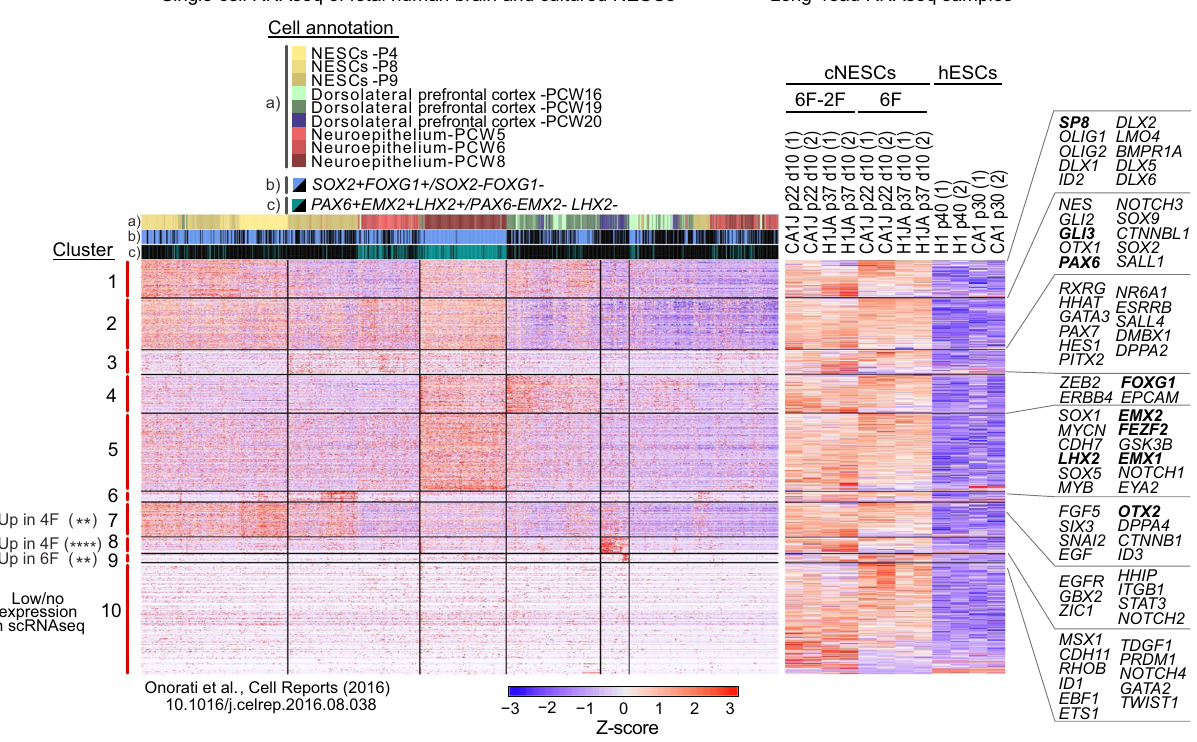
Fig. 6 Human developmental gene expression in cNESCs. Gene expression clustering heatmaps (as Z-score of log2(CPM + 1)) for single-cell RNA sequencing (scRNAseq) from foetal human brain tissue and cultured NESCs (Onorati et al ., 2016 38 ,) (left) and lrRNAseq of cNESCs and hESCs (right), for cNESC marker genes obtained from literature and differential expression analysis. Single cells are annotated according to a) their origin and b-c) expression of in vivo cortical progenitor markers (top). Genes of interest are highlighted, and dorsal forebrain markers are presented in bold. P = passage, PCW = post-conception week. Source data are provided as a Source Data fi